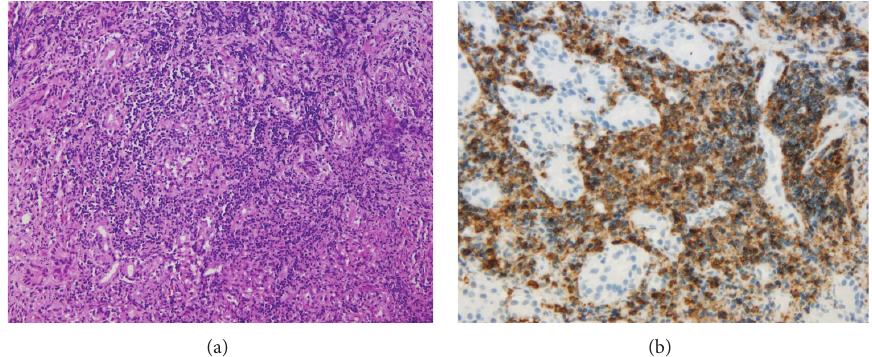
Figure 2: Orbit (a) histological appearance with diffuse lymphoid infiltrate H&E stain 10x and (b) immunohistochemistry study showing uniform B-cell population CD20, 40x.